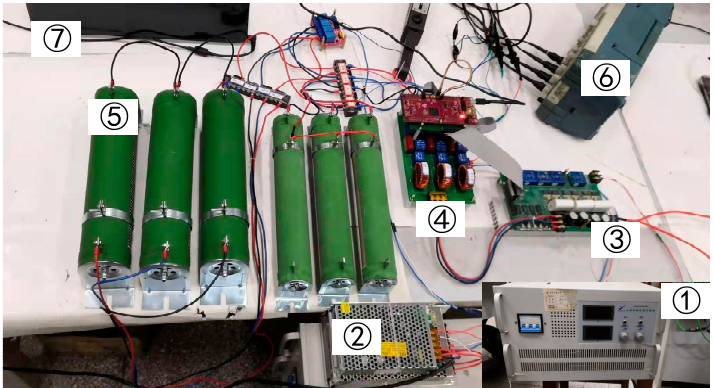
Figure 12. Experimental platform. ① DC power supply; ② Control power source; ③ Inverter bridge; ④ LC filters, sensors, and DSP; ⑤ Loads; ⑥ Oscilloscope; ⑦ Computer.